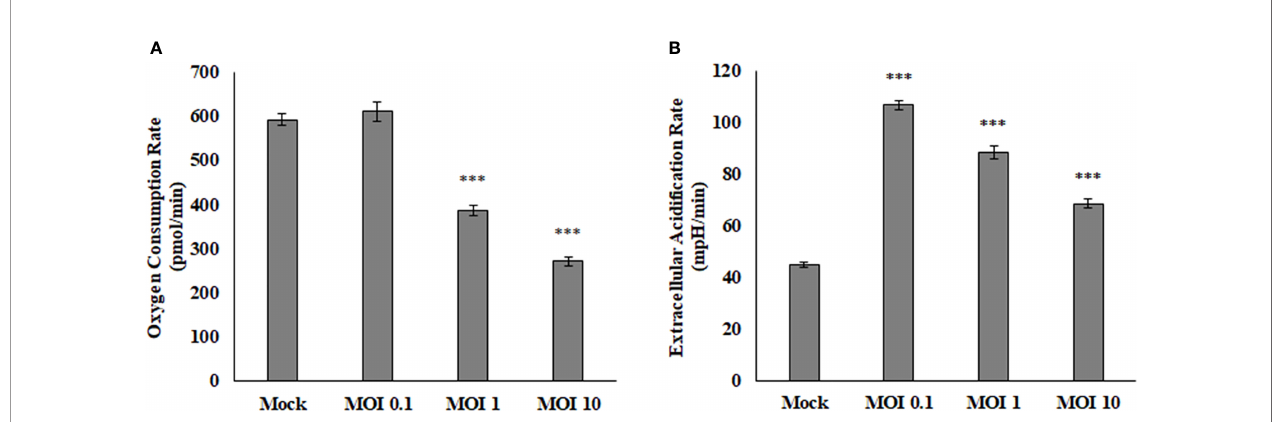
FIGURE 2 | Oxygen consumption rate (OCR, A ) is decreased during viral infection, while extracellular acidi fi cation rate (ECAR, B ) is increased during viral infection. These HEK cells were infected at various MOIs and allowed to infect for 24 hours before reading results. These values are normalized to the baseline reading just before injection of Oligomycin. *** P < 0.005